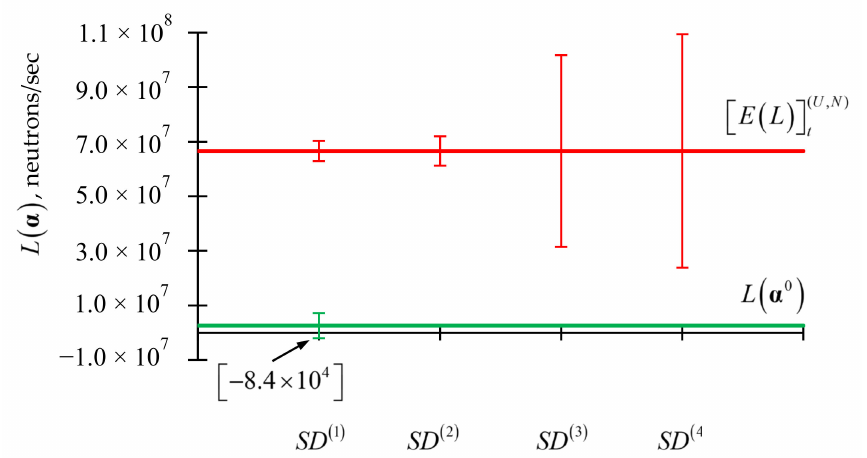
(cid:0) α 0 (cid:1) ± ( U , N ) ± SD ( 1 ) , SD ( 2 ) , SD ( 3 ) , SD ( 4 ) (in red), SD ( 1 ) (in green), [ E ( L )] t